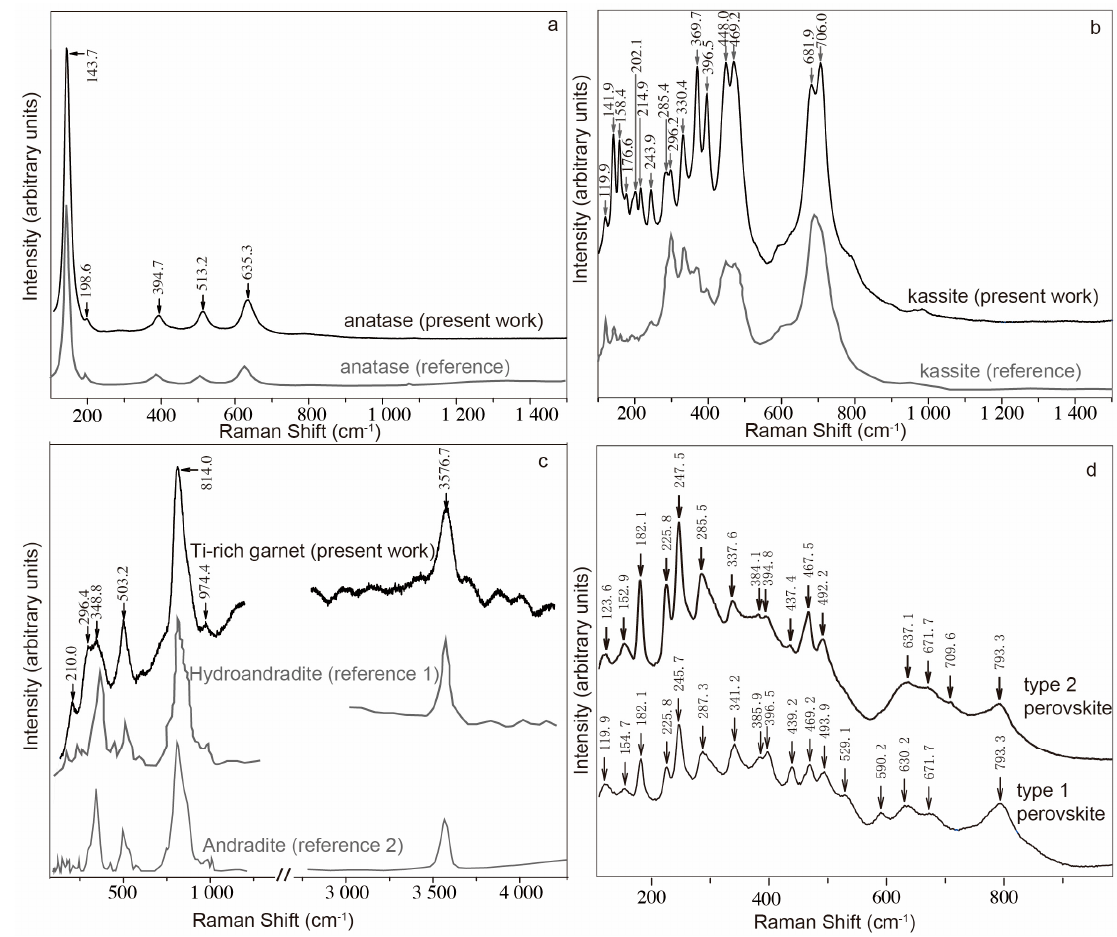
Figure 3. Representative Raman spectrum analysed in: ( a ) anatase from SK-1 kimberlite (present work) compared with anatase reference from Martins et al. [15], the last presents a peak at 1088 cm − 1 which corresponds to calcite; ( b ) kassite from SK-2 kimberlite (present work) compared with kassite from Martins et al. [15]; ( c ) Ti-rich garnet from SK-2 kimberlite, compared with grossular-hydroandradite from Ghosh et al. [33] and andradite from the RRUFF Project database (R060350) [34]; ( d ) type 2 perovskite replacing spinel and type 1 groundmass perovskite from SK-2 (present work).